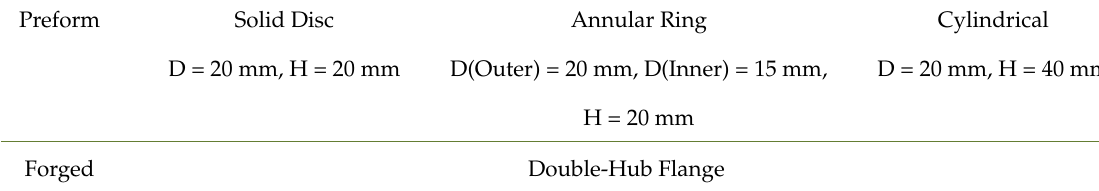
Table 2. Dimension of Preforms and Final Forged Component.